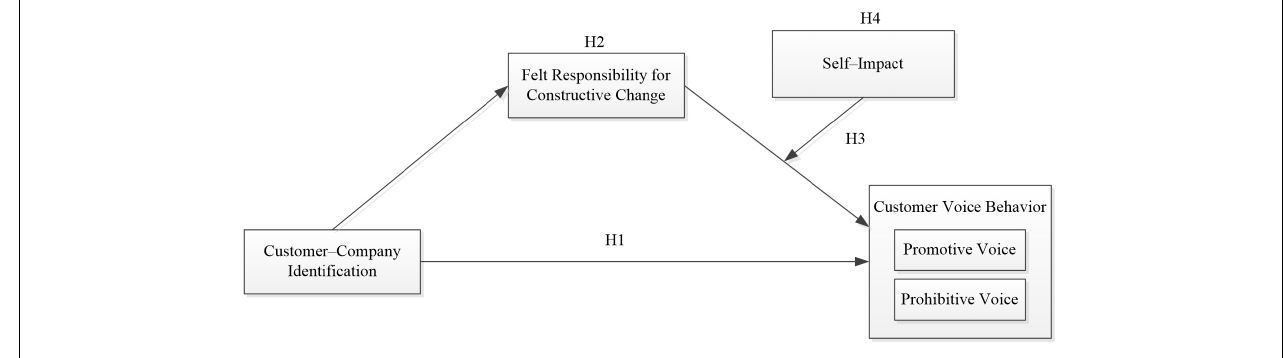
FIGURE 1 | Theoretical